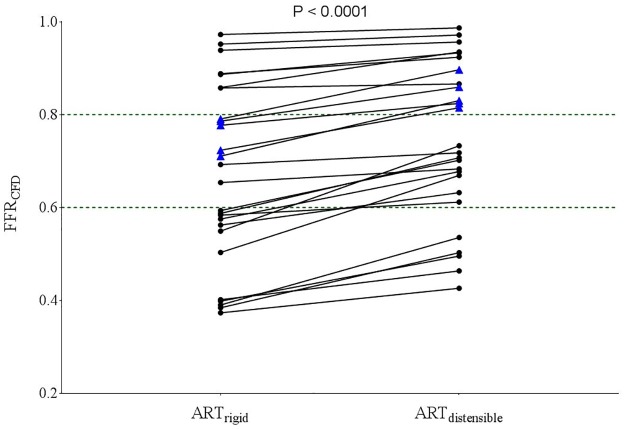
FFRCFD in ARTrigid and ARTdistensible models for 26 coronary arteries.Blue triangles represent the coronary arteries with FFR < 0.8 when modeled as rigid vessels and had FFR > 0.8 when modeled as distensible vessels.